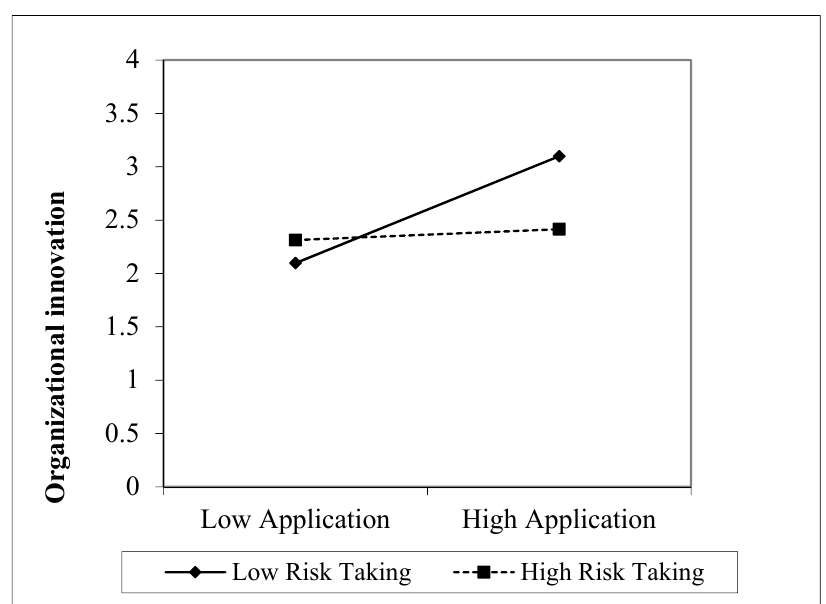
Figure 7. The moderating effect of risk-taking on the knowledge application–organizational innovation relationship. Source: Own elaboration.